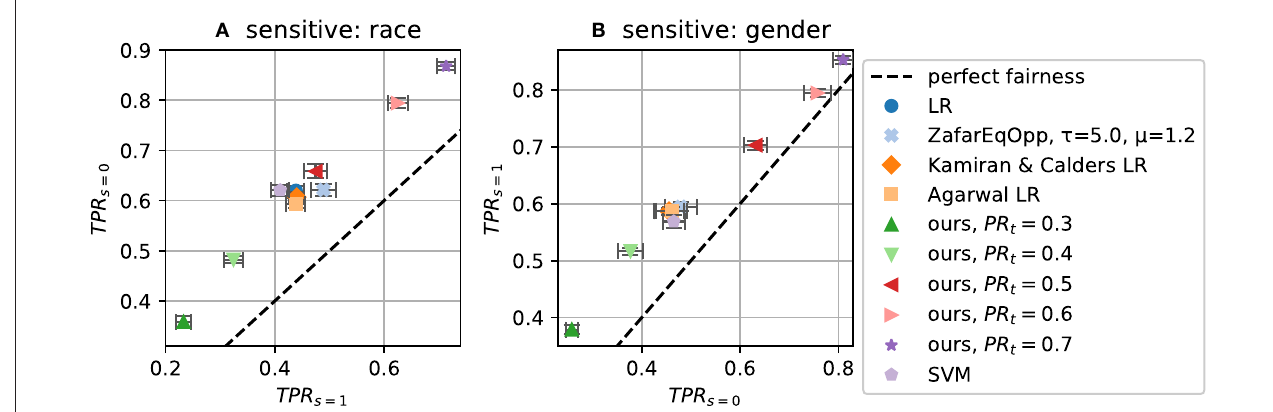
FIGURE 5 | Fairness measure TPR s = 0 vs TPR s = 1 ( equality of opportunity ) for different target PRs ( PR t ). (A) On dataset ProPublica recidivism using race as the sensitive attribute; (B) using